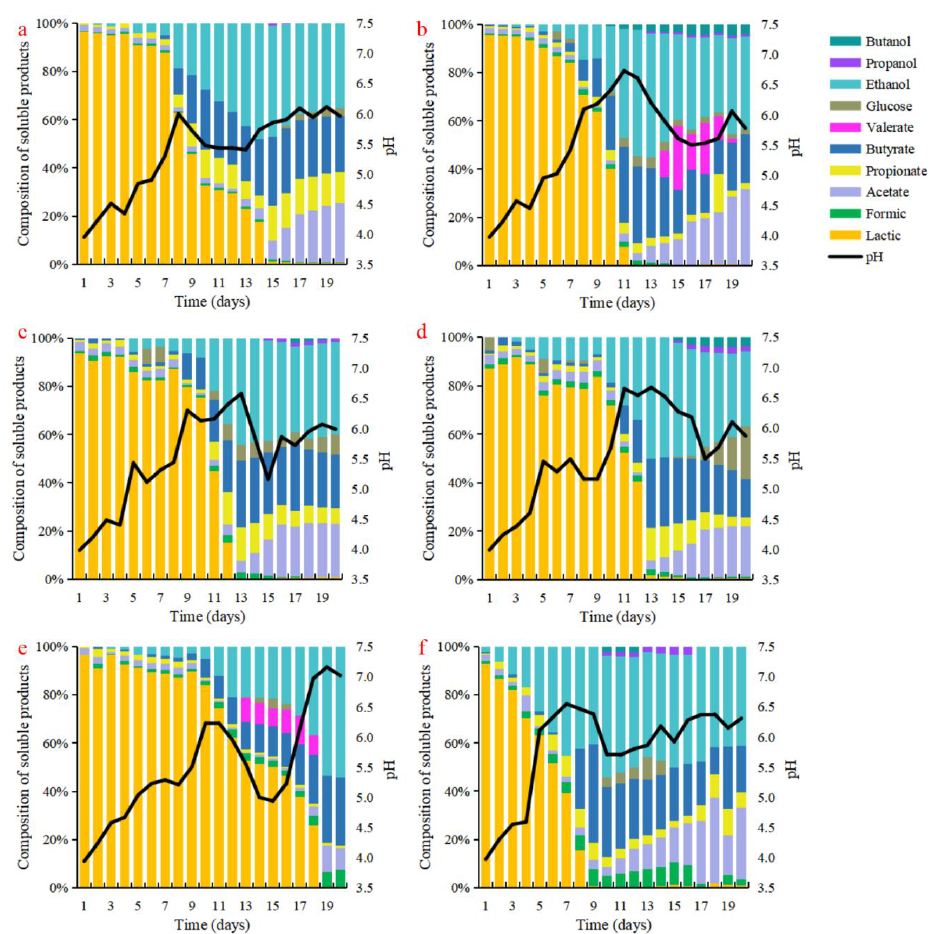
Figure 3. Changes of pH and the composition of soluble products along fermentation time. ( a ) Control, ( b ) beef tallow, ( c ) mutton fat, ( d ) soybean oil, ( e ) peanut oil, and ( f ) rapeseed oil in different treatments.